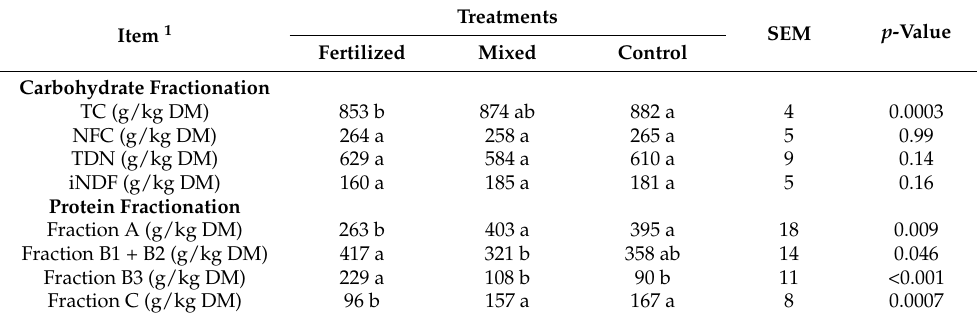
Table 1. Fractionation of herbage carbohydrate and protein of palisade grass fertilized with urea (150 kg N/ha/year), mixed with pintoi peanut (mixed) and without N fertilization (control). Average of 2 years of evaluation of 5 grazing cycles ( n =